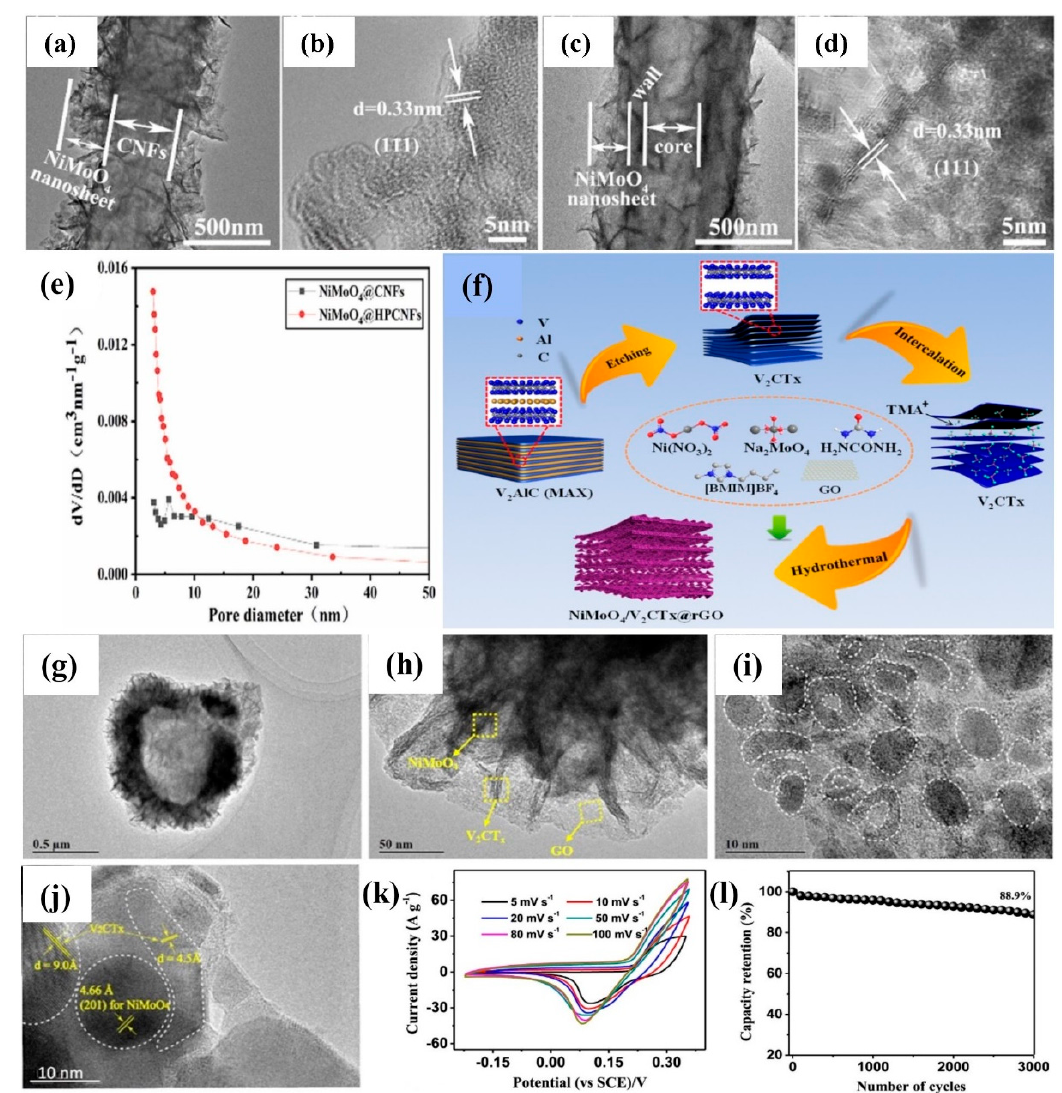
Figure 8. ( a , c ) SEM images of NiMoO 4 − CMFs and NiMoO 4 − HPCMFs, ( b , d ) TEM images of NiMoO 4 − CMFs and NiMoO 4 − HPCMFs, ( e ) Pore diameter distribution [142]. Reproduced from Ref. [142] with permission from Elsevier, 2022. ( f ) Schematic diagram of the formation of NiMoO 4 /V 2 CT x − rGO MXene, ( g , h ) TEM images of NiMoO 4 /V 2 CT x − rGO, ( i , j ) HRTEM images of NiMoO 4 /V 2 CT x − rGO, ( k ) CV curves at various scan rates, ( l ) Cycling stability at 10 Ag − 1 [144]. Reproduced from Ref. [144] with permission from American Chemical Society, 2021.